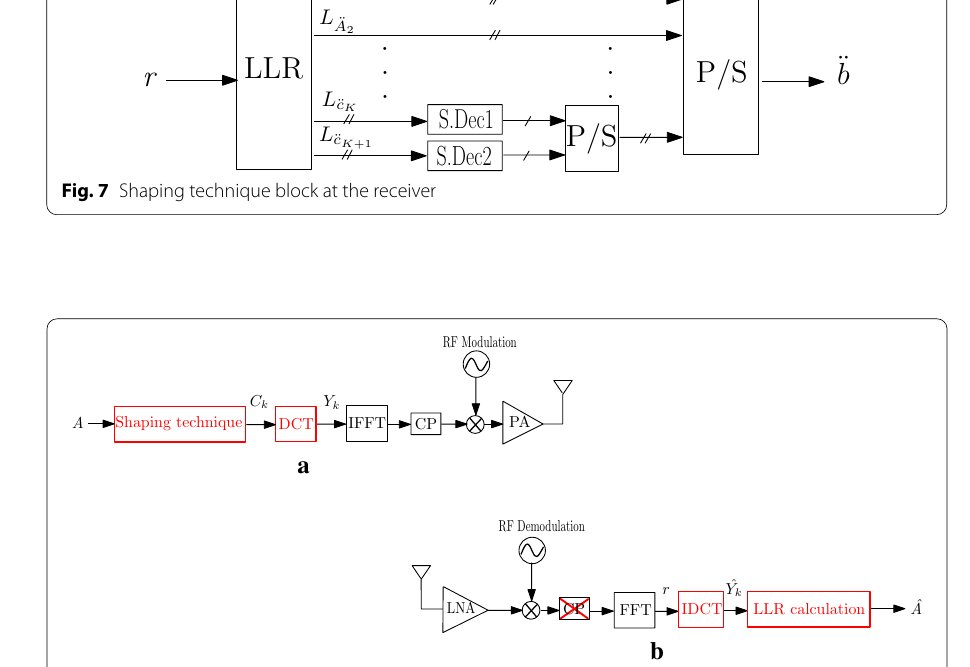
Fig. 8 The proposed OFDM system with shaping and DCT techniques a transmitter, b